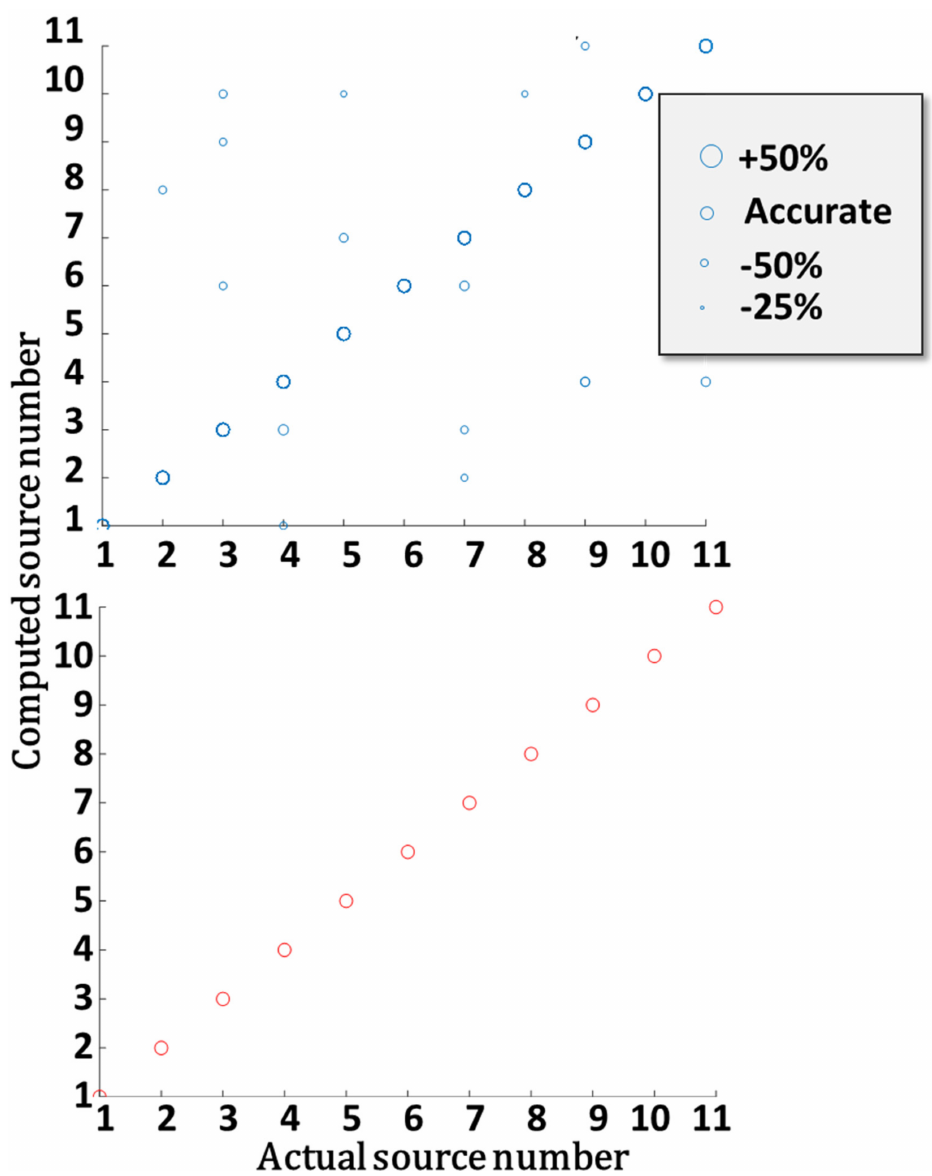
Figure 5. Computed vs. actual leak sources using a practical detector array. ( Top ): results using all feasible solutions. Computed leak rate accuracy is presented graphically, where underestimation of the leak rate is depicted in small circles and overestimation in large circles; see box legend. ( Bottom ): Same as above, only for the most accurate feasible solutions (T5) for each